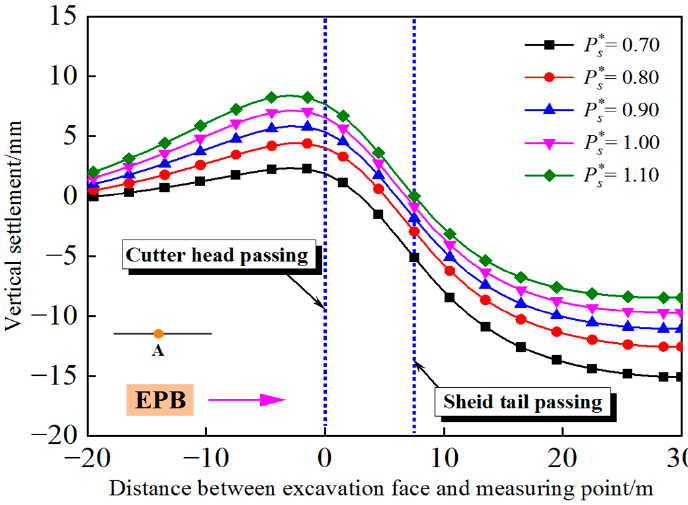
∗ P ∗ . Figure 13. Vertical settlement at point A under different support pressure ratios P s . s